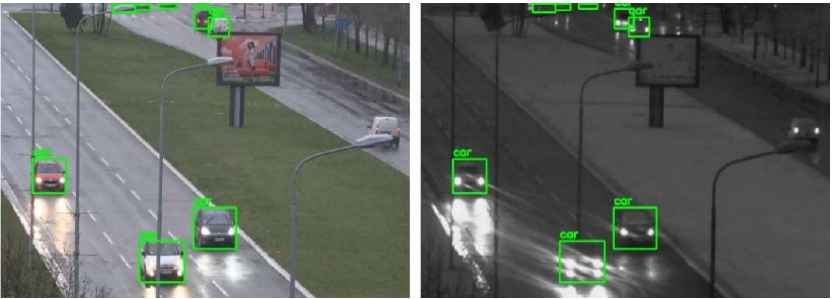
Figure 9. Mapping detections (car—green, person—red) from visible-light ( left ) to SWIR ( right ) image and missed car detection due to the partial occlusion of the streetlamp. 2. False detections on the color image—Figure 10.